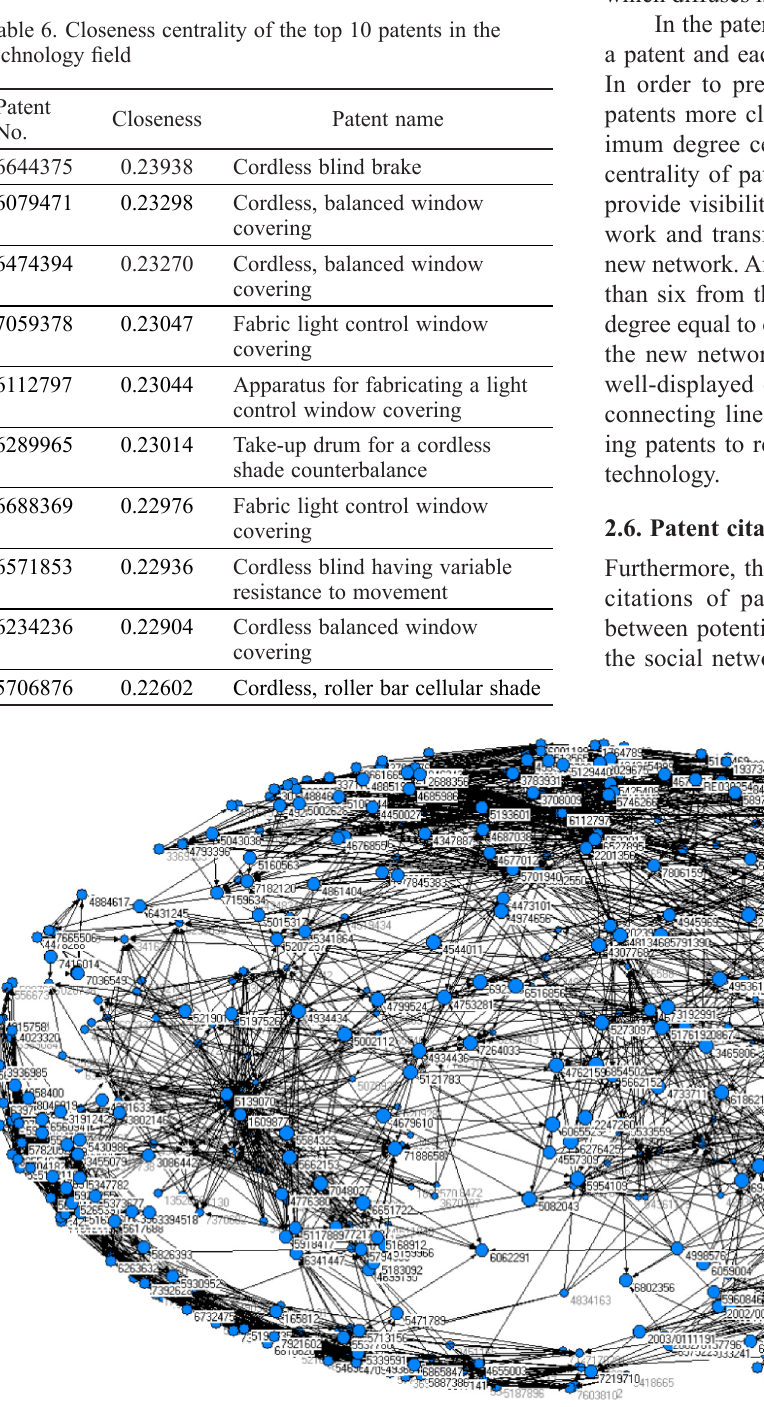
Fig. 5. Reduction of citation network of patents in the technology